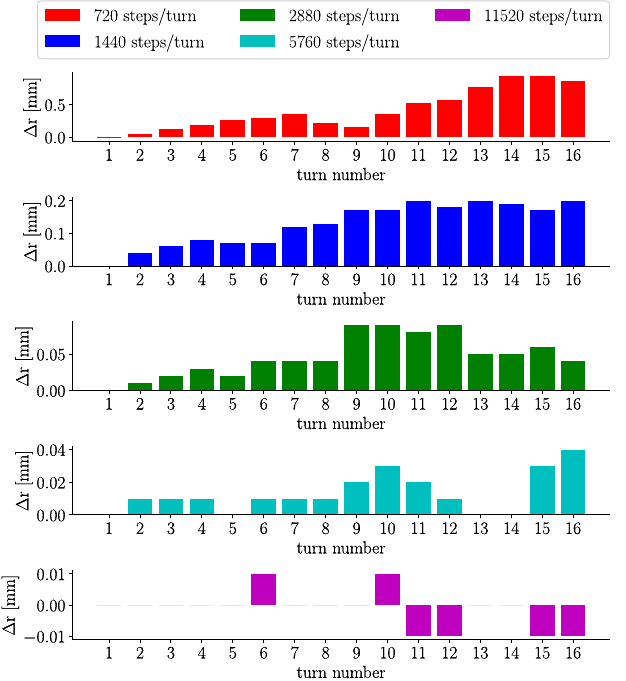
FIG. 15. Difference of the turn radius Δ r at probe RRI2 between simulations due to the number of integration steps per turn. The reference simulation uses 23 040 steps per turn. The input parameters of the simulation are optimized for 2880 steps per turn.